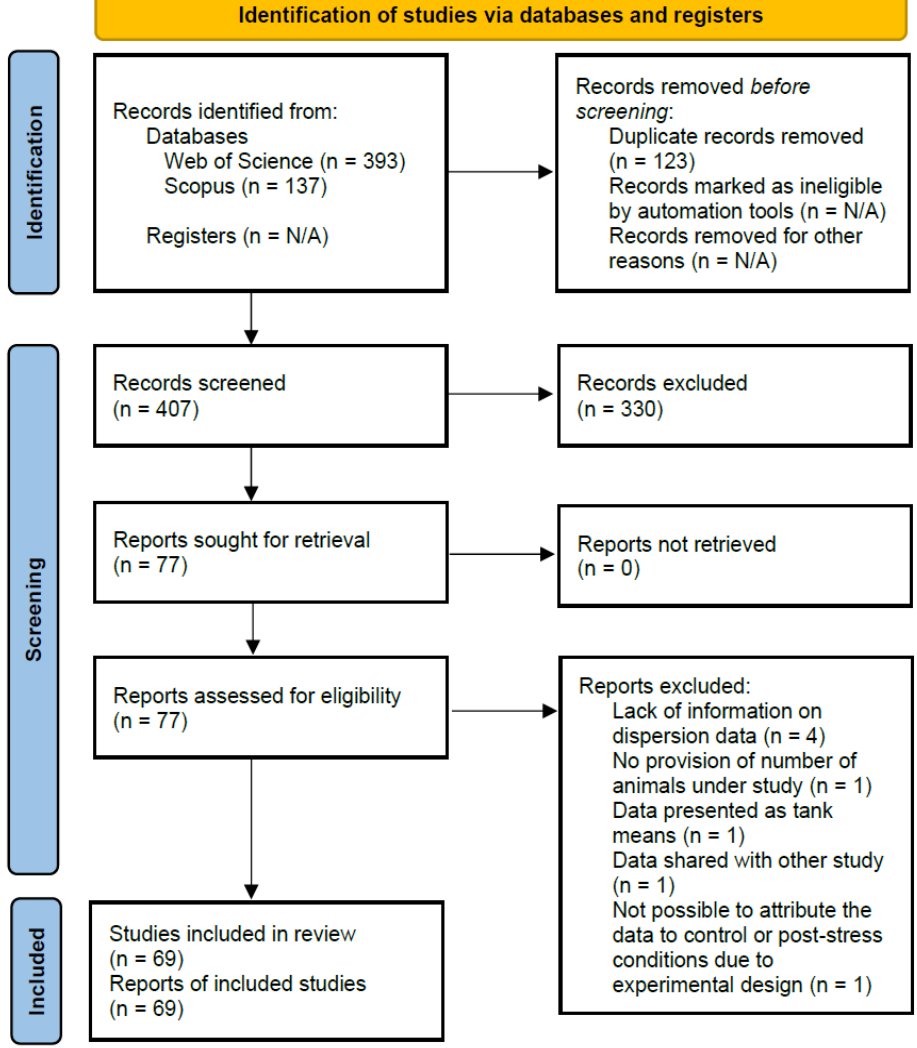
Figure 1. Flow diagram showing phases of systematic review and study selection for meta-analy- sis.